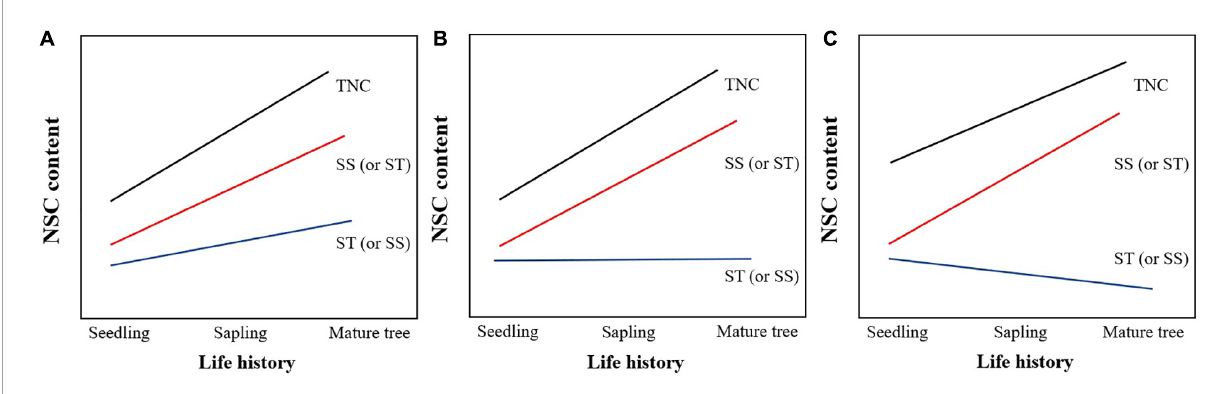
FIGURE1 Hypothetical diagram of the changing trend of non-structural carbohydrates (NSC) content with life history. (A) SS and ST both tend to increase; (B) one of SS and ST tends to increase and the other is in a stable state; (C) one of SS and ST shows an increasing trend and the other shows a decreasing trend, but the increase will be greater than the decrease.